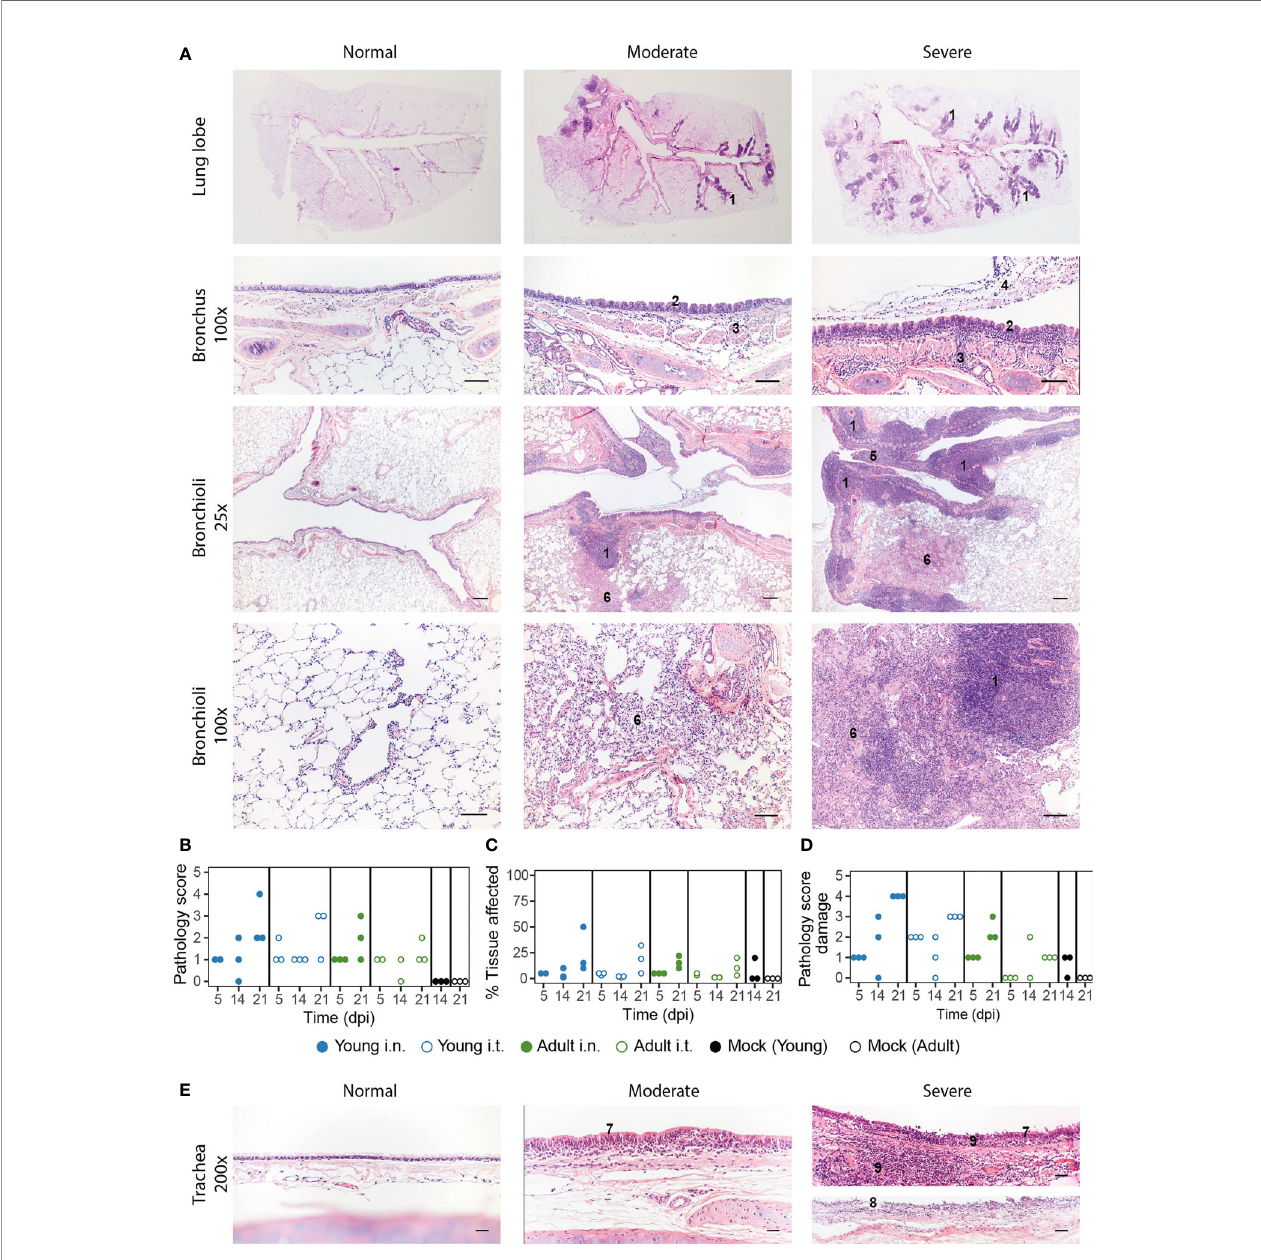
FIGURE 4 | Pathology aspects of lung and trachea. (A) Representative haematoxylin and eosin stained sections of normal, moderately and severely affected respiratory tissues at overview, 25x and 200x magni fi cation. Lungs of SARS-CoV-2 infected animals with a clear hyperplasia of the Bronchus-Associated Lymphoid Tissue (BALT), consisting of activated lymphocytes that penetrate through the muscle layer of the bronch(iol)us into the lamina propria and submucosa (indicated in fi gure with ‘ 1 ’ ). Hyperplasia of bronchial epithelium visible as repeated bumps (2), cellular in fi ltrate into the submucosa (3) and exudate in the lumen (4) were also observed. The presence of hyper-plastic follicles led to obstruction of bronchiole (5). Some animals displayed desquamative interstitial pneumonia, with pulmonary macrophages in the alveoli and to a minor extent, lymphocytes and plasma cells (6). The alveolar epithelium (pneumocytes) exhibited squamous-like characteristics. Images are taken from placebo ferrets ( ‘ normal ’ ) or SARS-CoV-2 infected ferrets 14 or 21 dpi ( ‘ moderate ’ , ‘ severe ’ ). (B-D) Pathology was summarized in an overall score ranging from 0-5 based on the parameters described in the materials and methods. Pathology score (B) and % of tissue affected (C) for lung tissue and pathology score for trachea (D) . With exception of ‘ Adult i.t. ’ on 14 dpi (n = 2), all groups are n = 3. (E) Representative haematoxylin and eosin stained sections of normal, moderately and severely affected trachea tissue slides at 200x magni fi cation. Pathological aberrations in the trachea consisted of hyperplasia (7), damage and pseudo-squamous characteristics of the epithelium (8) and in fi ltration of in fl ammatory cells into the submucosa and epithelium of the trachea (9). Images are taken from SARS-CoV-2 infected ferrets 5 ( ‘ normal) or 21 dpi ( ‘ moderate ’ , ‘ severe ’ ).Bars represent 200µm, 100µm and 50µm at respectively 25x, 100x and 200x magni fi